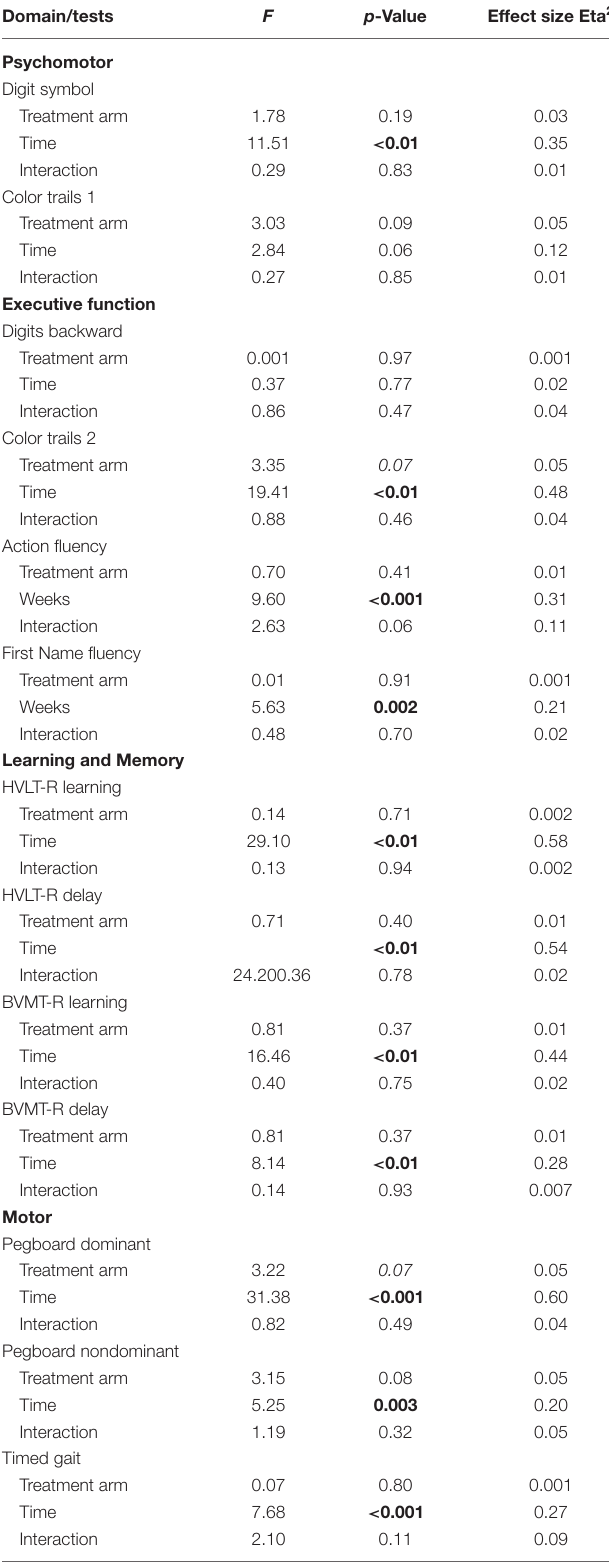
TABLE 4 | Change in neurocognitive performance among HIV-HCV participants.